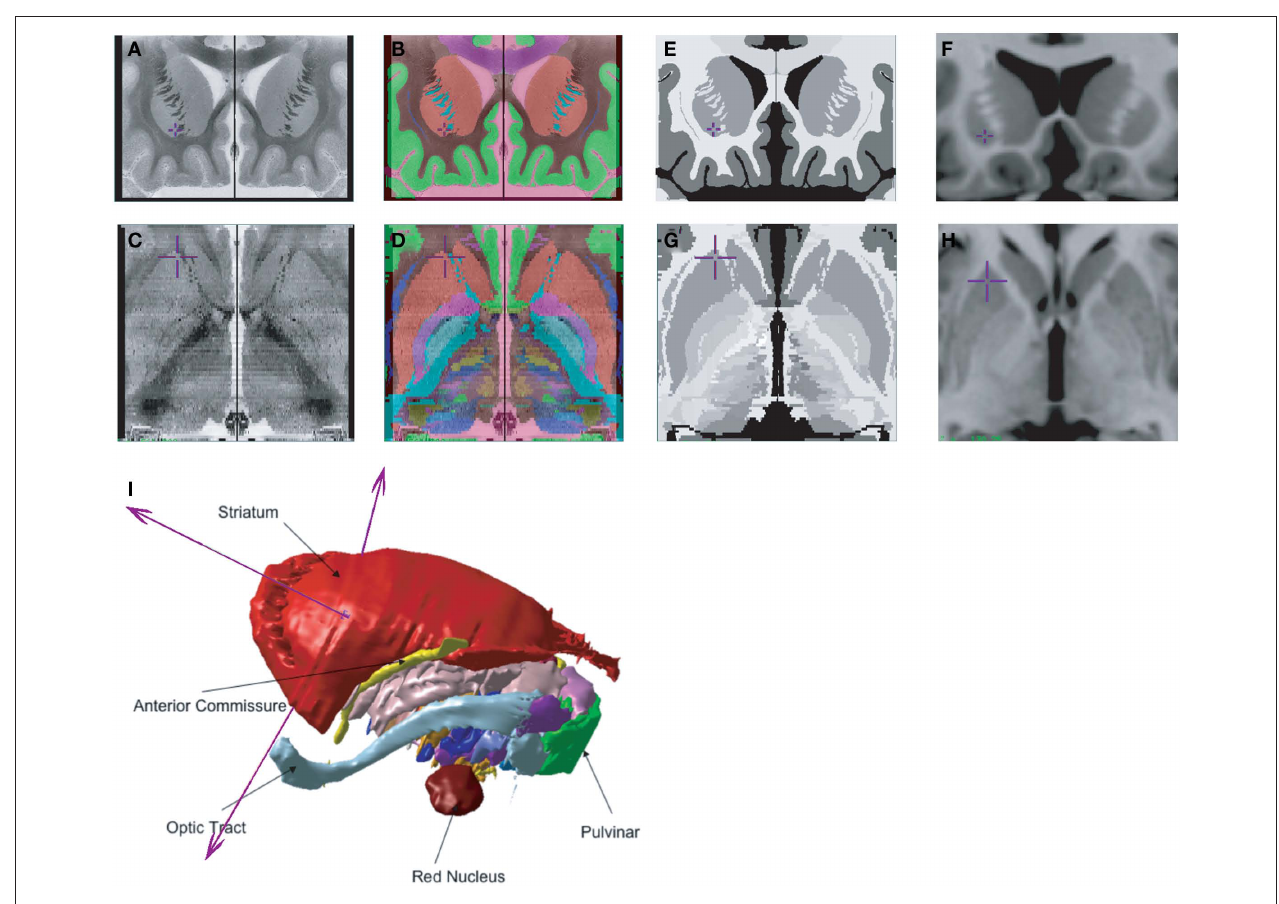
data (e) , with a reformatted axial view (g) . The pseudo-MRI is created by modifying the intensity of the labels in the voxel-label atlas (B) to a high-contrast, high-resolution MRI templates (F,H) The pseudo-MRI is then used to estimate a non-linear transformation which matches the atlas to a high-resolution template MRI volume, or directly to a patient or participant’s MRI (i) . 3D geometric atlas created from the 3D surface rendering of labels in the voxel-label atlas